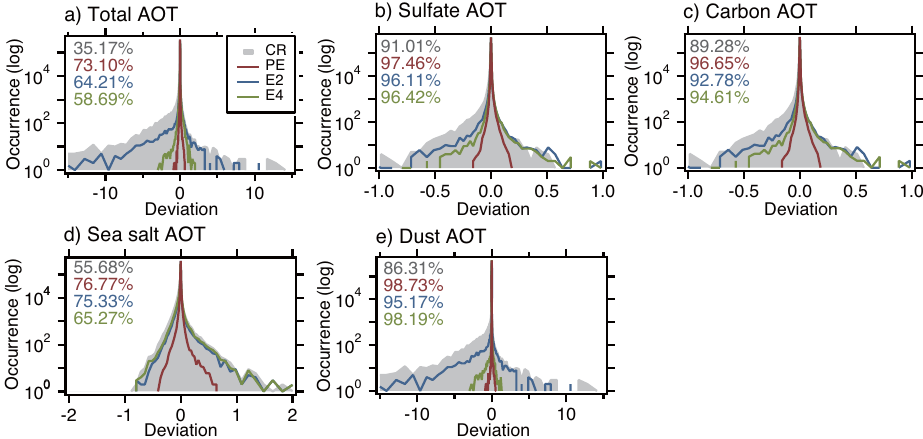
Fig. 8. Histograms of deviations (NR minus CR, and NR minus AR) for (a) total, (b) sulfate, (c) carbon, (d) sea-salt, and (e) dust AOTs. Grey shading shows NR minus CR. The numbers in the panels are the fractions of the deviations between − 0.05 and 0.05.